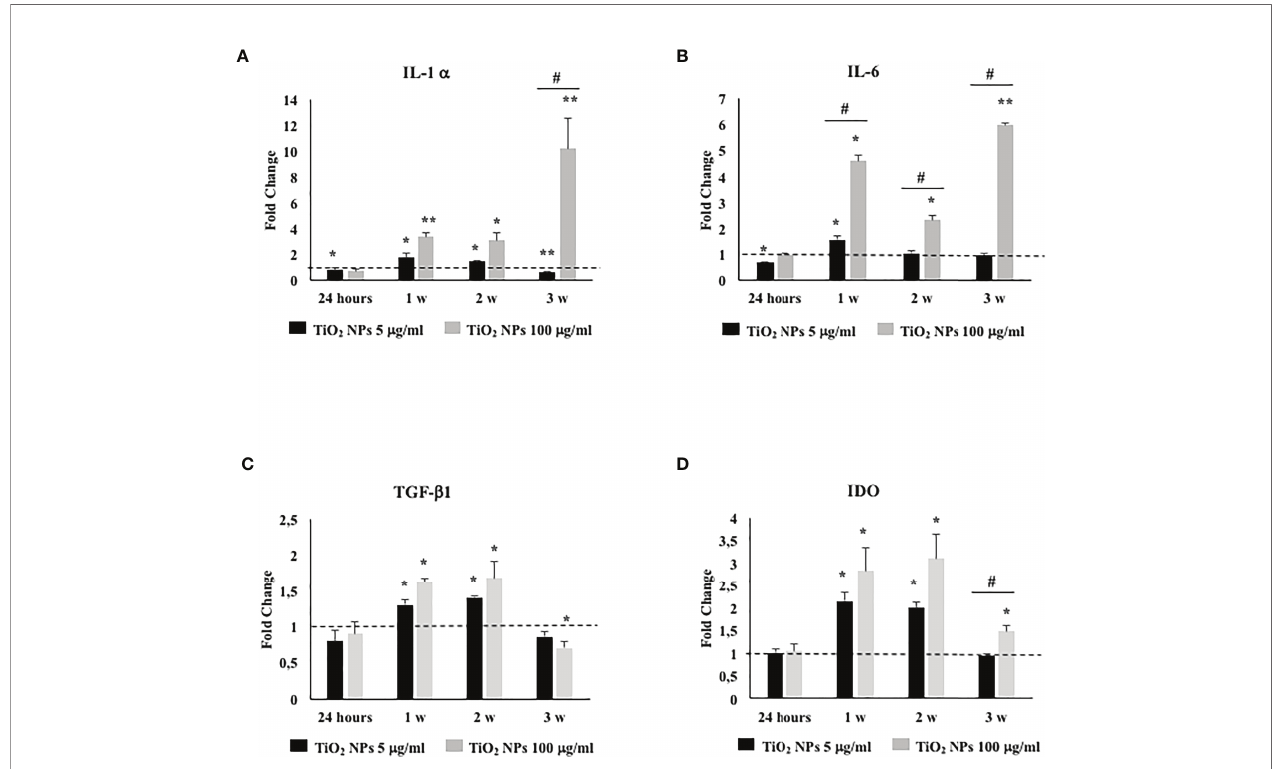
FIGURE 9 | Real-time PCR analysis of SCs proin fl ammatory and immunomodulatory response. Gene expression of IL-1 a (A) , IL-6 (B) , TGF- b 1 (C) , and IDO (D) in SCs at 24 h and 1, 2, and 3 weeks of incubation with TiO 2 NPs 5 (black bar) and 100 µg/ml (grey bar). Data represent the mean ± SEM (* p < 0.05, ** p < 0.001 vs. unexposed SCs (black dotted line) and # p < 0.05 vs. 5 µg/ml of TiO 2 NPs of three independent experiments, each performed in